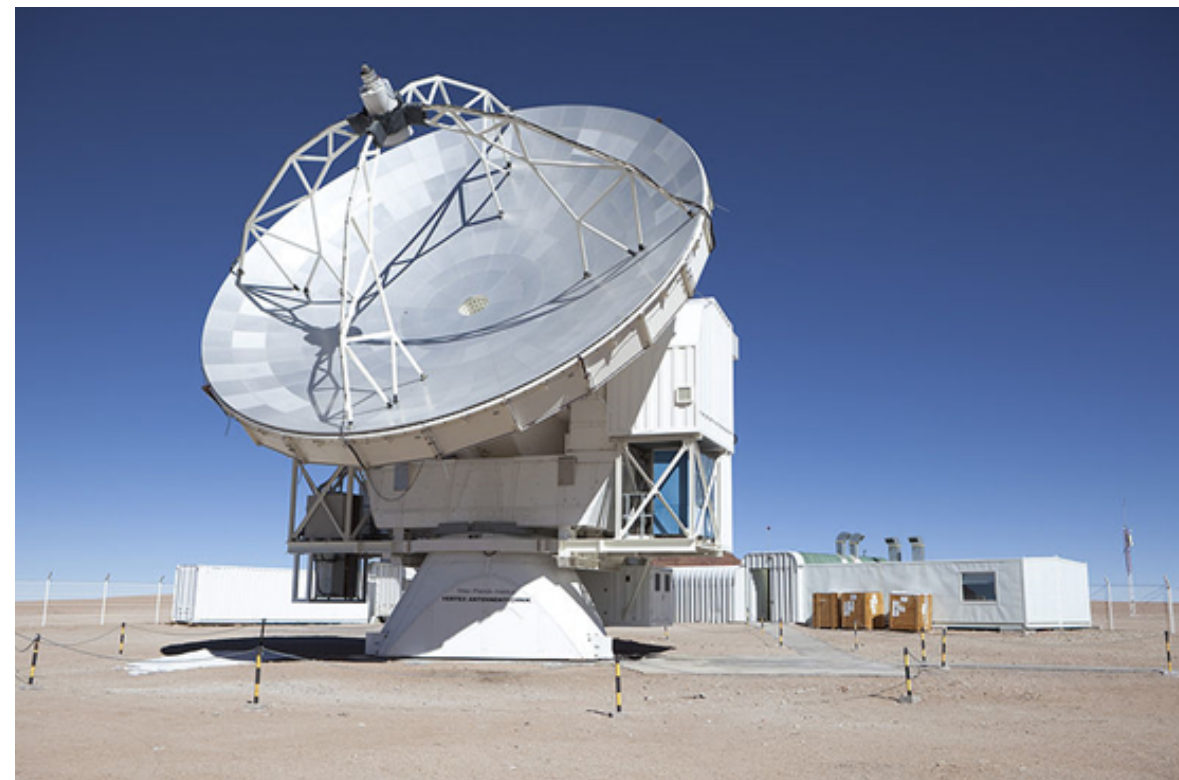
Figure 1. LLAMA will resemble this antenna, APEX, which is situated close to ALMA, and belongs to an European